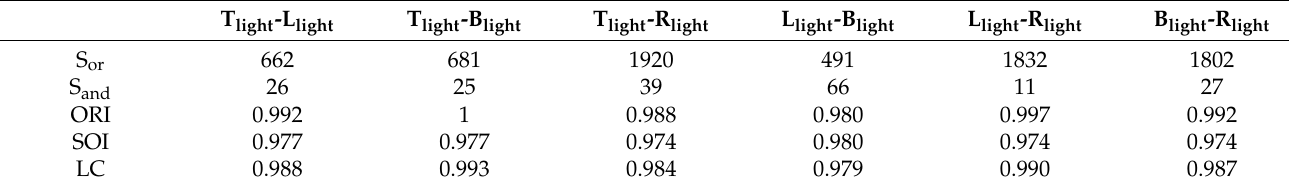
Table 5. Process data statistics for lighting solutions under Viewpoint